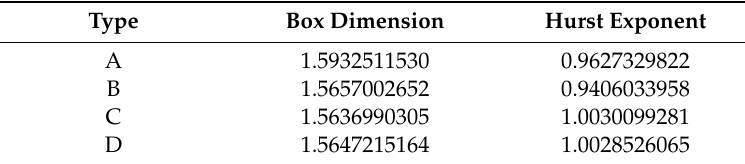
Table 3. Mean comparison of the fractal dimension from tactile signals.